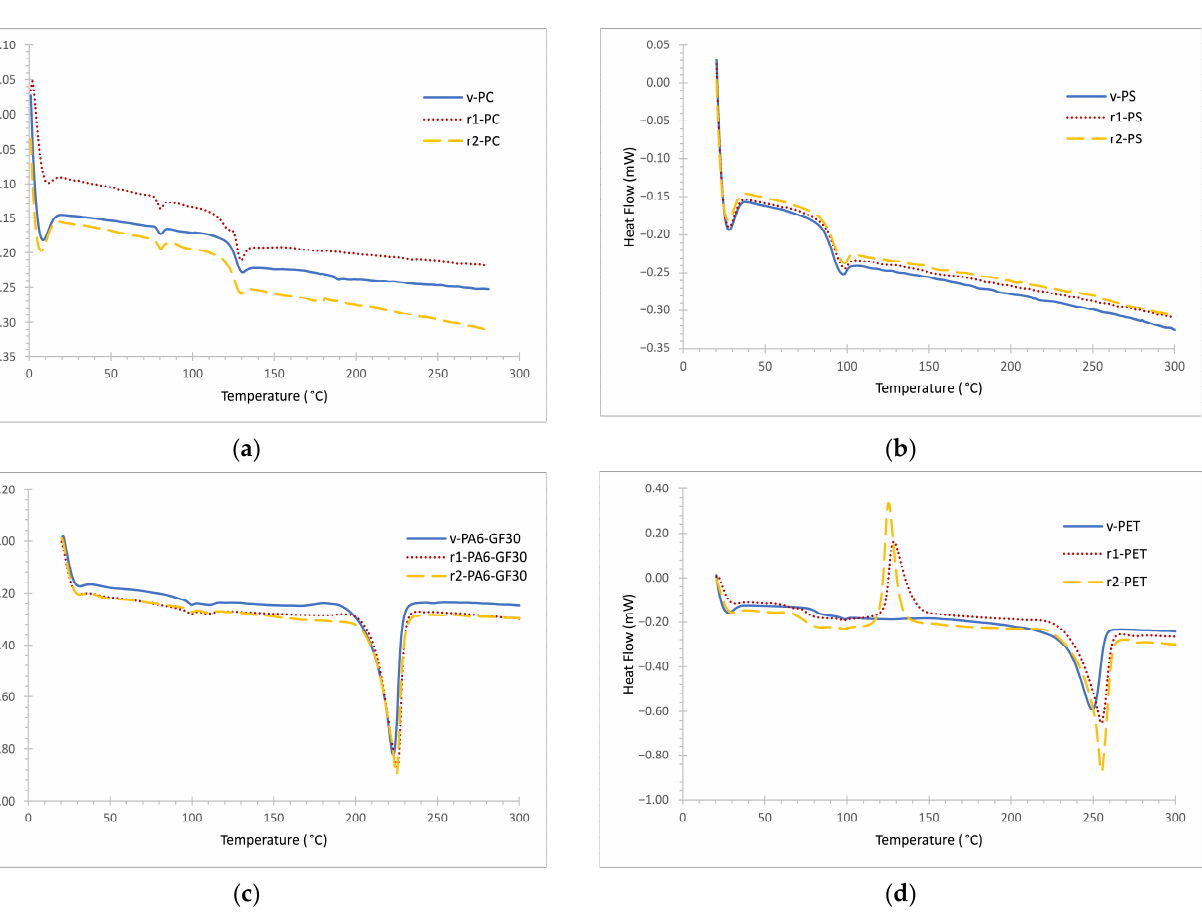
Figure 2. DSC analysis of the virgin and recycled materials: ( a ) PC; ( b ) PS; ( c ) PA6-GF30; and ( d )